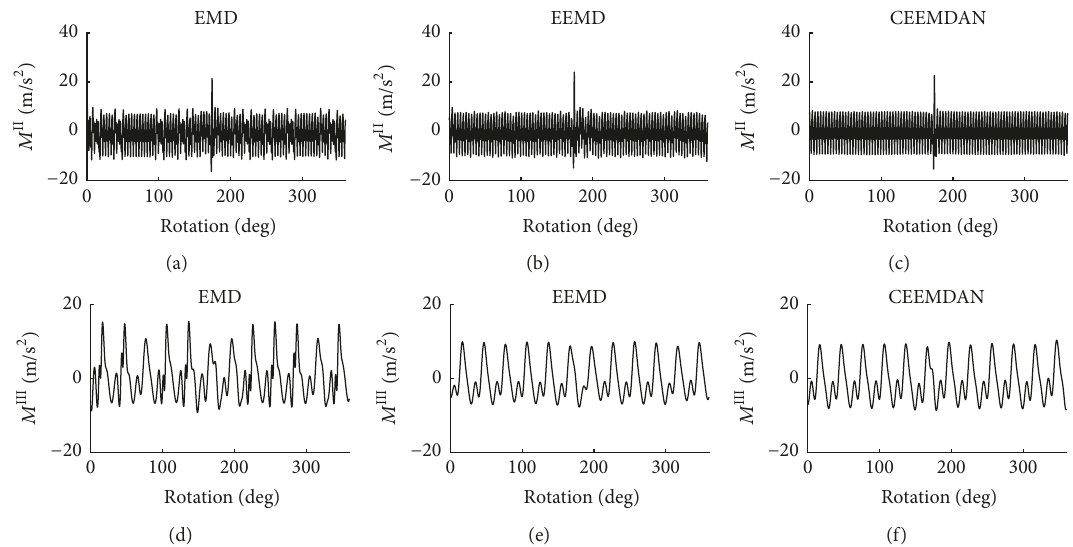
Figure 10: Representative signals for (a–c) gear II and (d–f) gear III in the case of the simulated signal with localized fault in gear